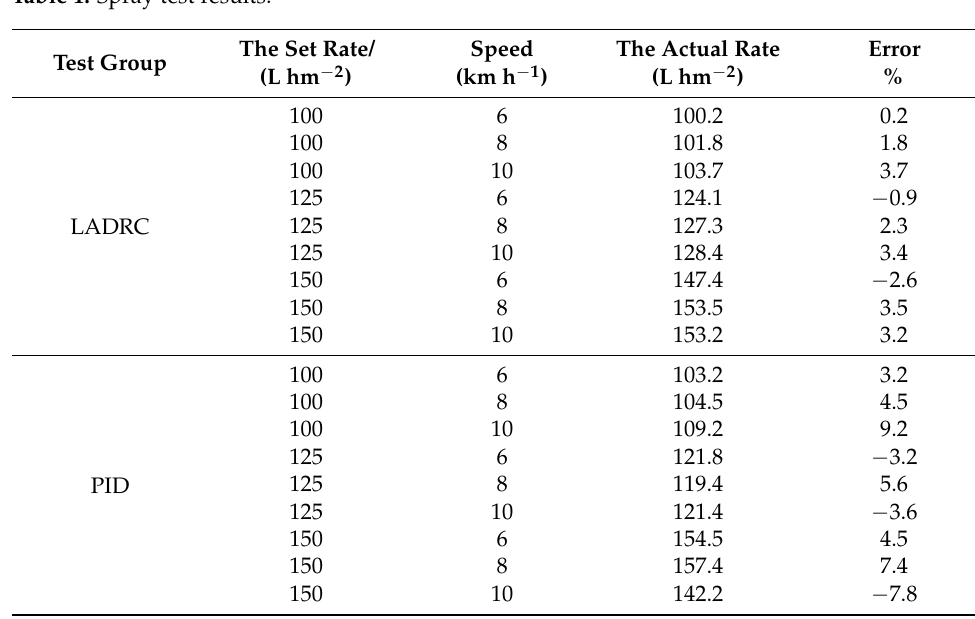
Figure 13. Field spray quantity data curve (uniform motion). Table 1. Spray test results.